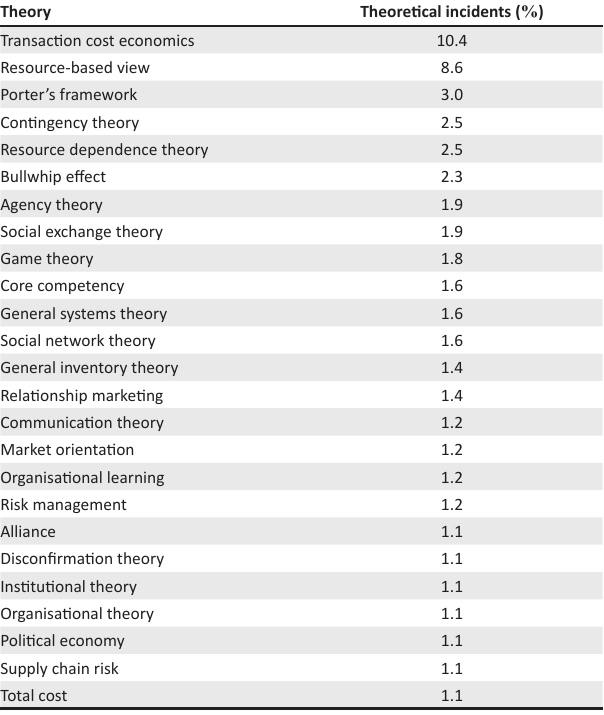
TABLE 3: Twenty-five most frequently identified theories